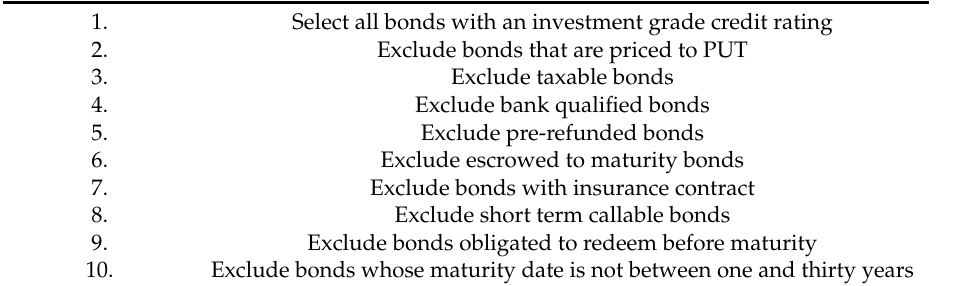
Table 1. Bonds selection